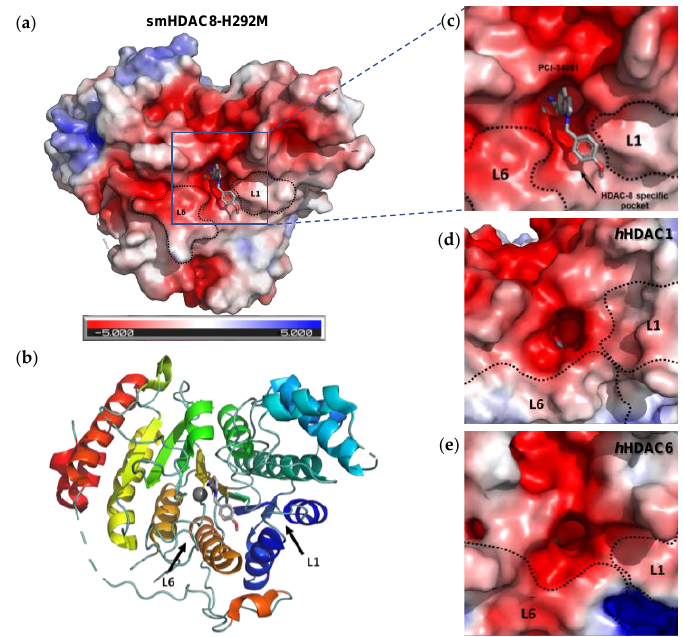
Figure 2. Representation of sm HDAC8-H292M in complex with 1 (PDB code: 6HSF), shown as ( a ) electrostatic potential surfaces, and ( b ) ribbon and sticks structure. Delineation of the L1 and L6 loops forming the walls of the catalytic pocket of HDAC8, HDAC1, and HDAC6: close-up representation of the electrostatic potential surfaces of ( c ) crystal structure of mutant sm HDAC8-H292M in complex with compound 1 (PDB code: 6HSF), ( d ) crystal structure of h HDAC1 (PDB code: 4BXK), ( e ) crystal structure of h HDAC6 catalytic domain 2 (CD2) (PDB code: 5EDU). PCI-34051 ( 1 ) is depicted in light grey. Co-crystal structures were downloaded from the Protein Data Bank and visualized by Pymol (PyMOL TM